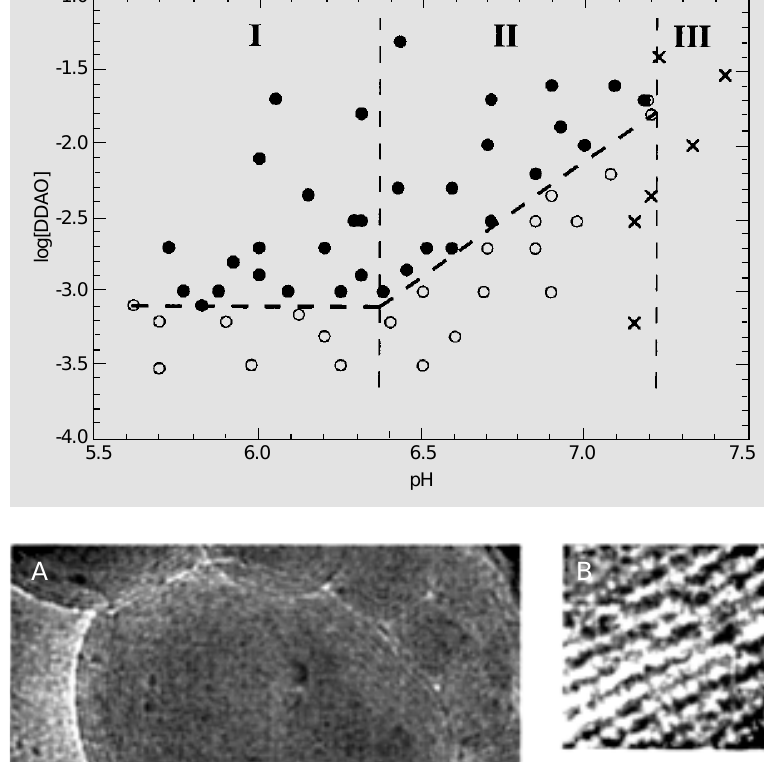
Figure 11. Multilamellar structures formed in DNA- dodecyldimethylamine oxide (DDAO):dioleoyl- phosphatidylethanolamine (DOPE) mixtures under acidic conditions (pH = 5.5). A , Cryo-TEM image of vitrified DNA-mixed vesicles complexes in 50 mM NaCl aqueous solutions (scale bar = 90 nm). B , Magnified detail of the multilamellar pattern from A. C , Fourier transforms of B. D , Precipitated DNA- (DDAO:DOPE) complexes (DNA:DDAO molar ratio is 1:1). Reprinted from Ref. 51, with